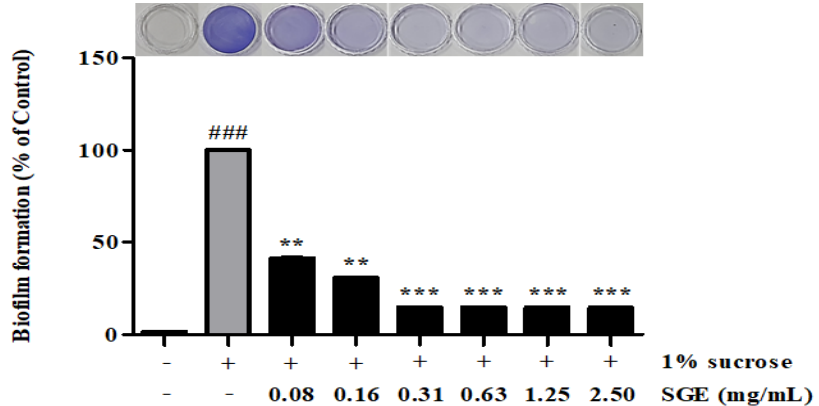
Figure 4. Inhibition of biofilm formation of SGE. Using 1% sucrose as a substrate, the biofilm-formation inhibitory effect of SGE on the biofilm produced by S. mutans was confirmed. After treatment at the indicated concentration for each extract, incubated for 24 h, the biofilm formation was measured using a microplate reader. Values are mean ± SD. ### p < 0.001 vs. non-treated group, ** p < 0.01, *** p < 0.001 vs. 1% sucrose-treated group.